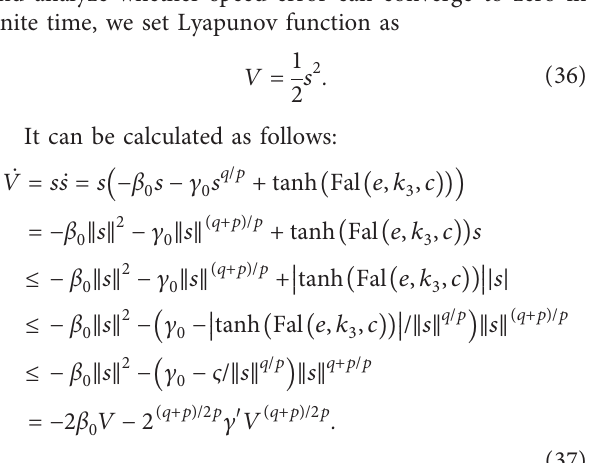
Figure 5: Properties of the tanh ( Fal ( e, β ,c ))